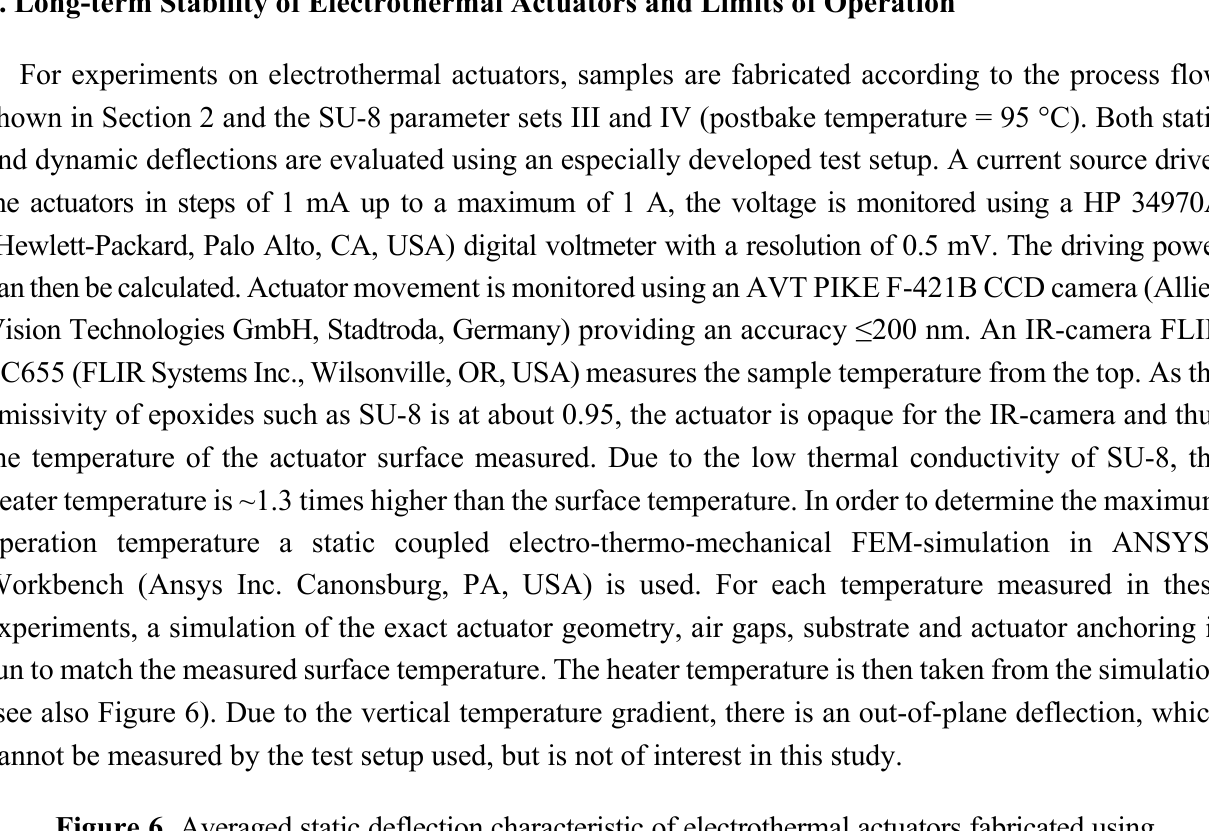
Figure 6. Averaged static deflection characteristic of electrothermal actuators fabricated using parameter sets III and IV (see Table 1) with measured surface and heater